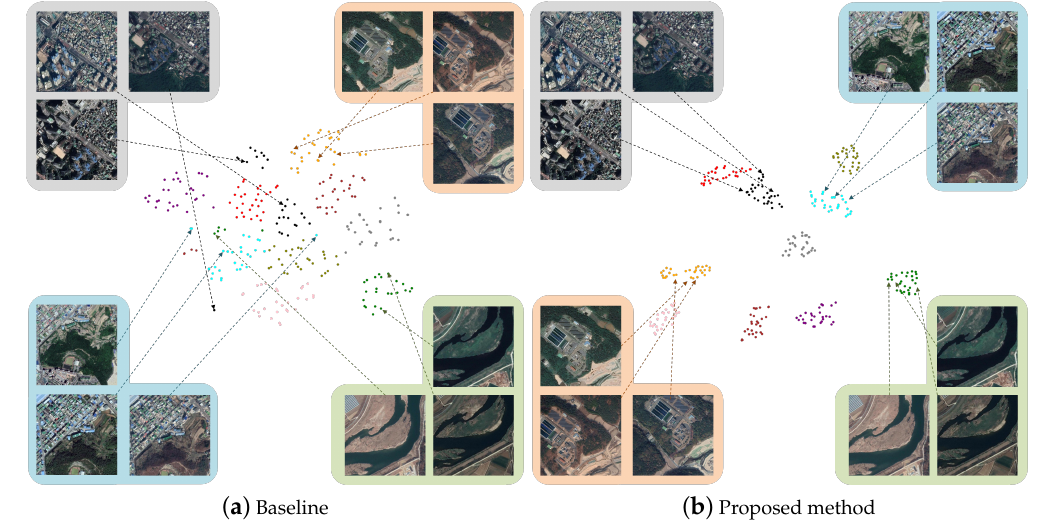
Figure 12. t-SNE figure before and after